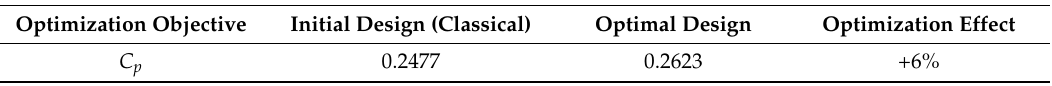
Table 5. Comparison of main performance parameters.